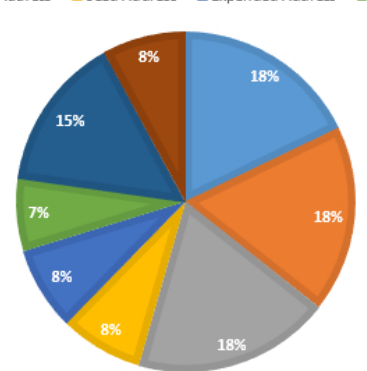
Figure 23. The most relevant features of the UGRansome dataset.